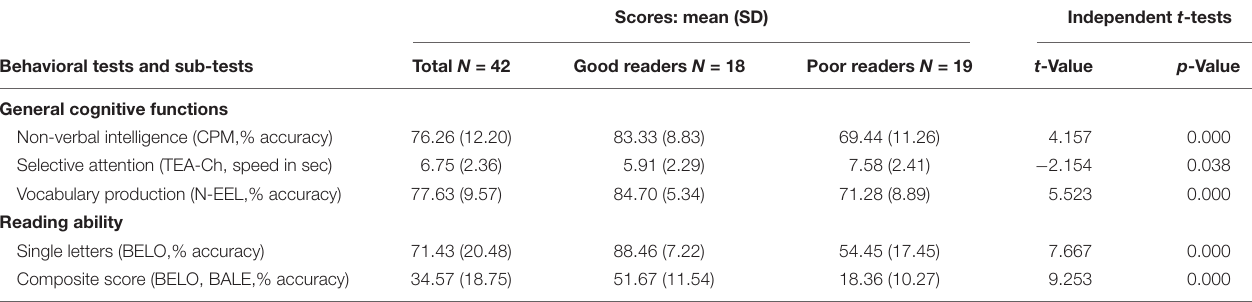
TABLE 1 | Behavioral scores for the cognitive and reading assessment for the whole group ( N = 42) and per subgroup.